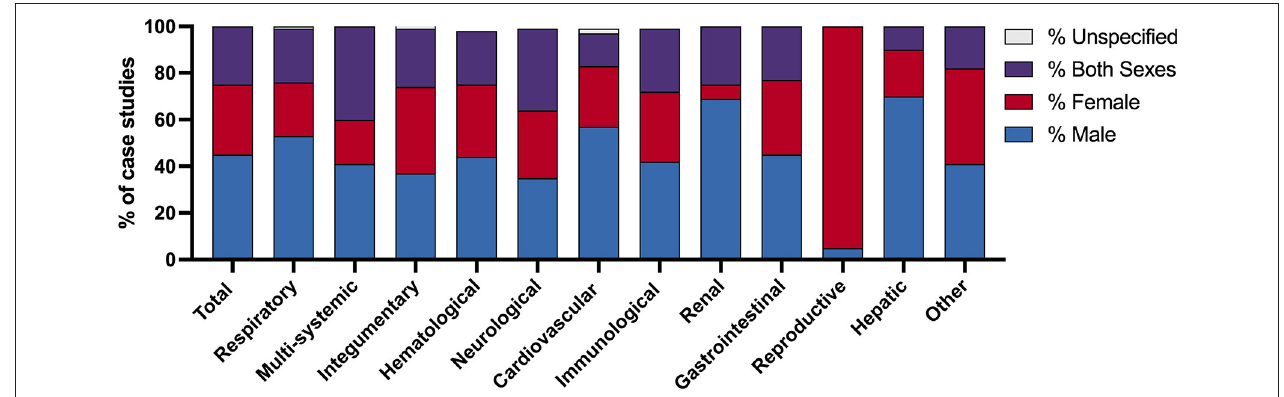
FIGURE 2 | Comparison of Covid-19 case studies by patient sex and physiologic body system. The percentage of Covid-19 case studies which describe patient sex as male, female, both sexes, and unspecified. Data are presented by the category of case study, coded by physiologic body system, as well as the sum of all case studies